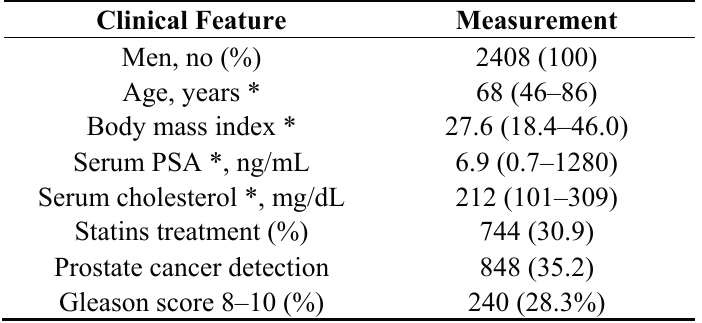
Table 4. Overall demographics and clinical characteristics of enrolled